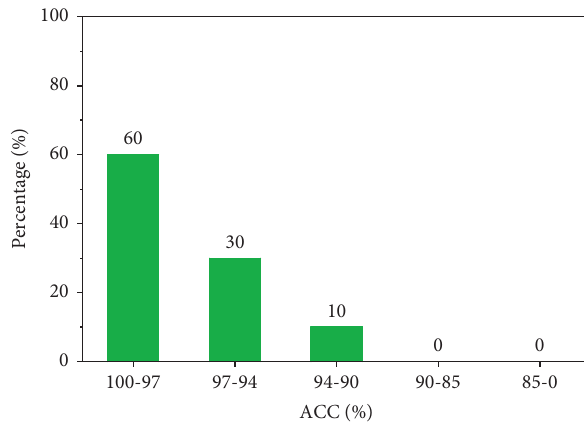
Figure 19: Training accuracy distribution for right turn.